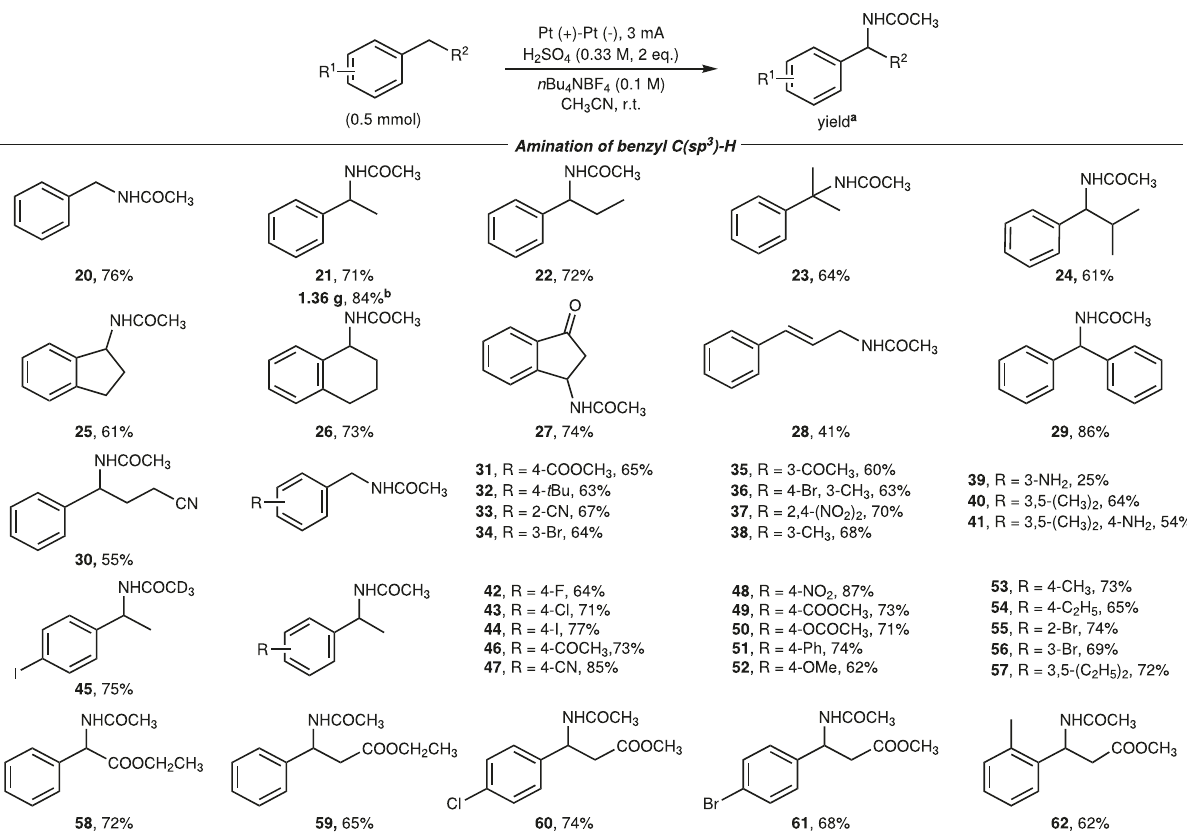
Fig. 3 Reaction scope of arene-containing substrates. a Isolated yield; b Electrolysis performed on 10 mmol scale.